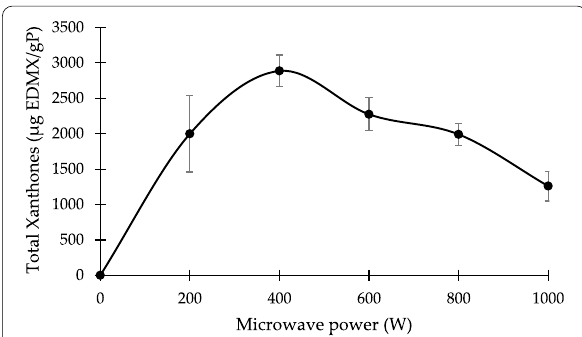
Fig. 3 Effect of microwave power on the concentration of xanthones during microwave-assisted extraction